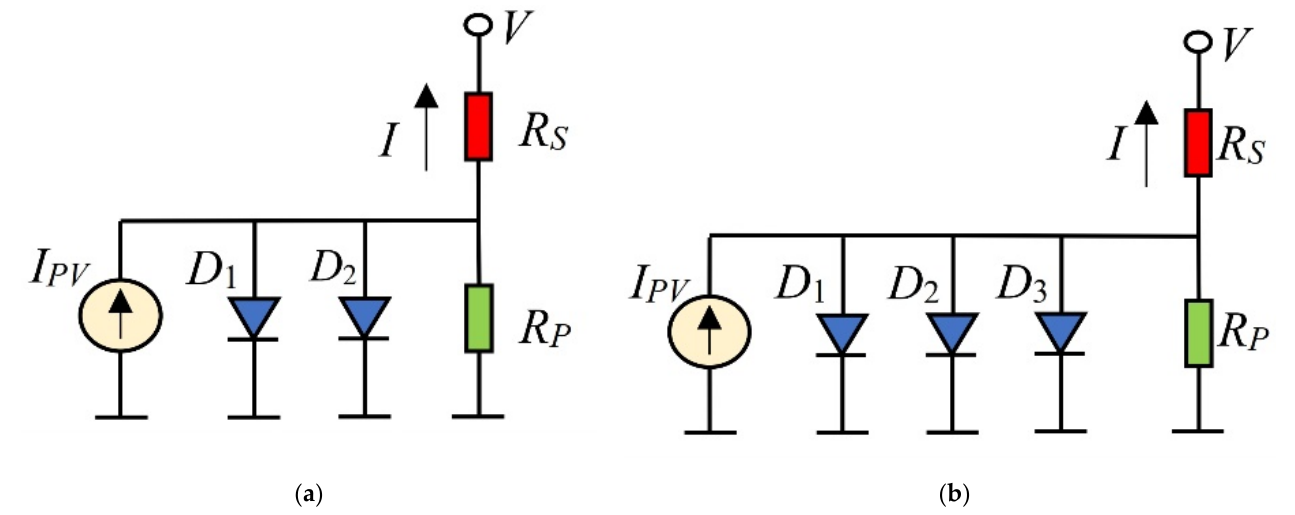
Figure 1. Equivalent circuit models of solar cells: ( a ) DDM; ( b ) TDM.